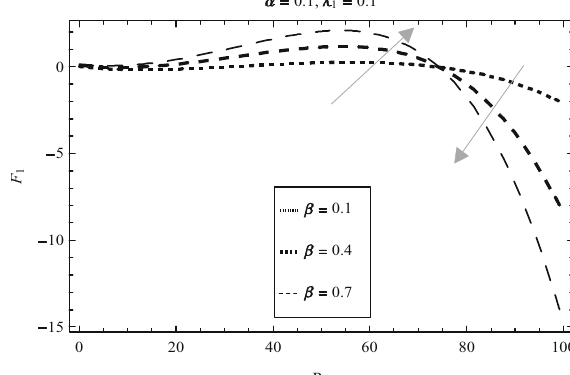
Fig. 18 Variation of F 1 along Re for different values of β